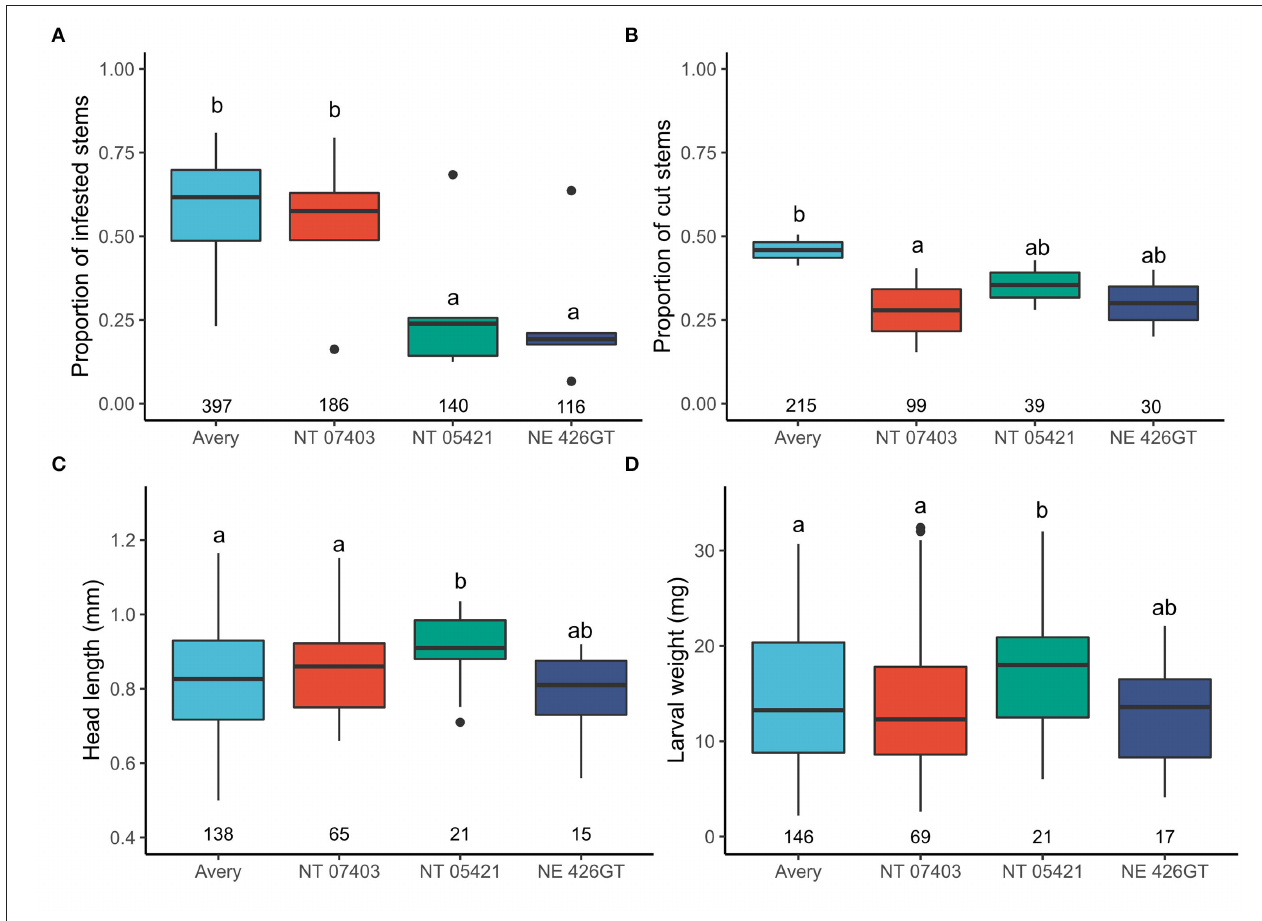
FIGURE 3 | (A) Effects of triticale genotypes and wheat on the proportion of stems infested with wheat stem sawfly, (B) on the proportion of stems that contained frass and were cut by the wheat stem sawfly, (C) on wheat stem sawfly larval weight, (D) on wheat stem sawfly larval head capsule length. N is represented by the numbers beneath each boxplot (total stems cut). Letters indicate significant pairwise differences ( P < 0.05, Tukey HSD corrected post hoc test). Pairwise comparisons and estimated marginal means, provided in Supplementary Figure 1